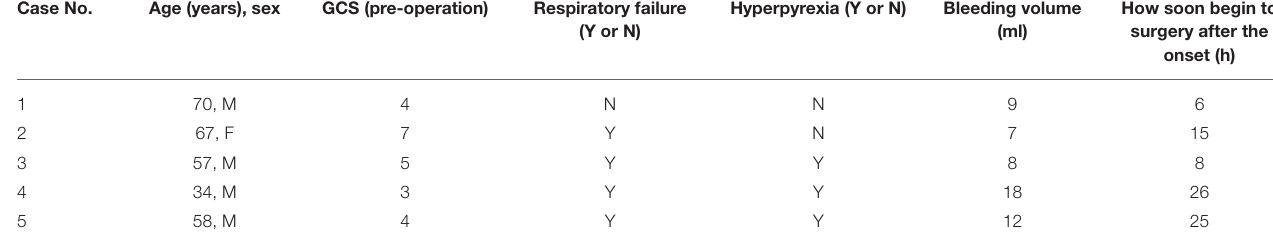
TABLE 1 | The basic information of patients. Case No.